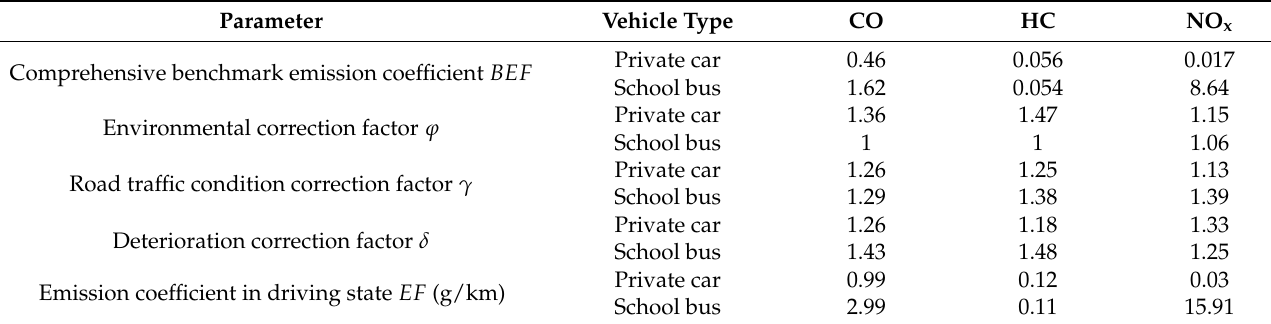
Table 7. Emission coefficient in driving state.